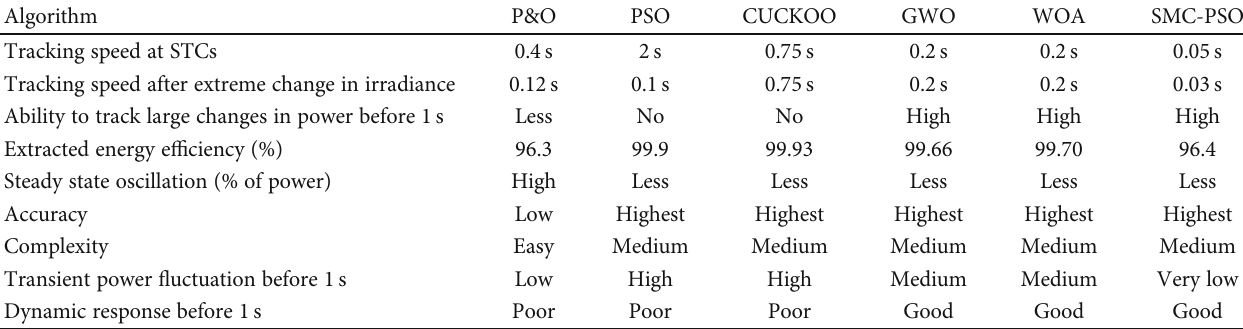
Table 2: Comparison of MPPT algorithms for the scenario